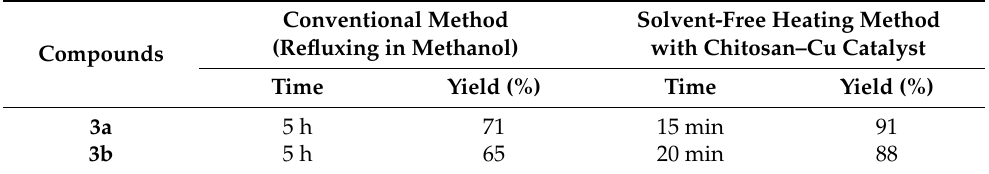
Table 1. Synthesis of spiropyrolidines derivatives ( 3a – b ).